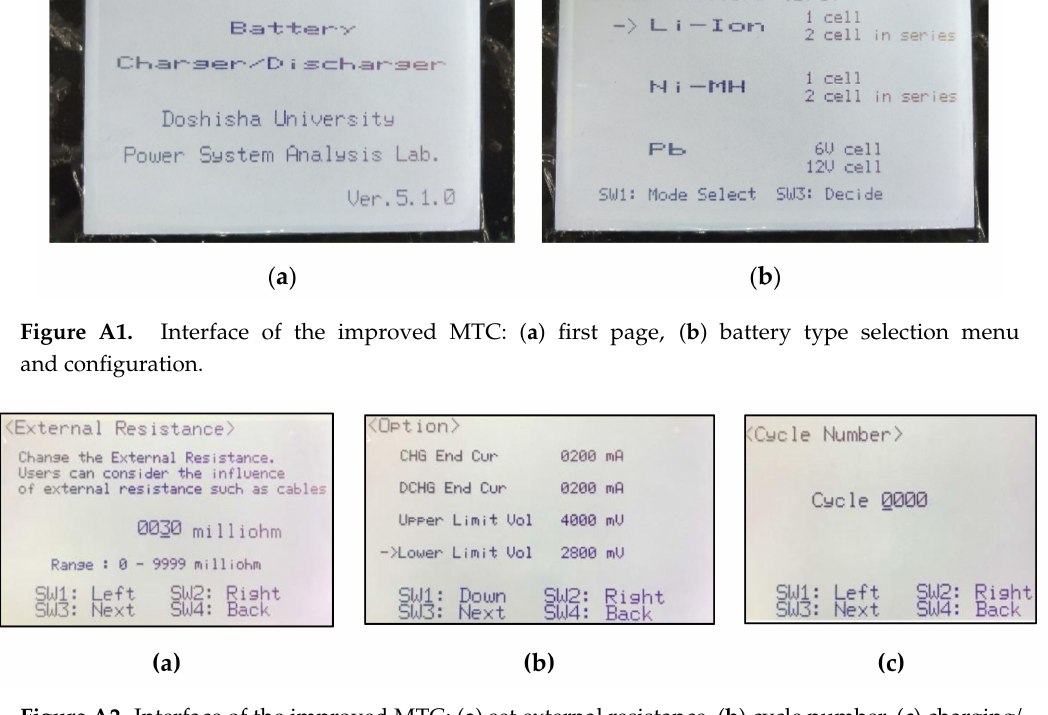
Figure A2. Interface of the improved MTC: ( a ) set external resistance, ( b ) cycle number, ( c ) charging / discharging protection